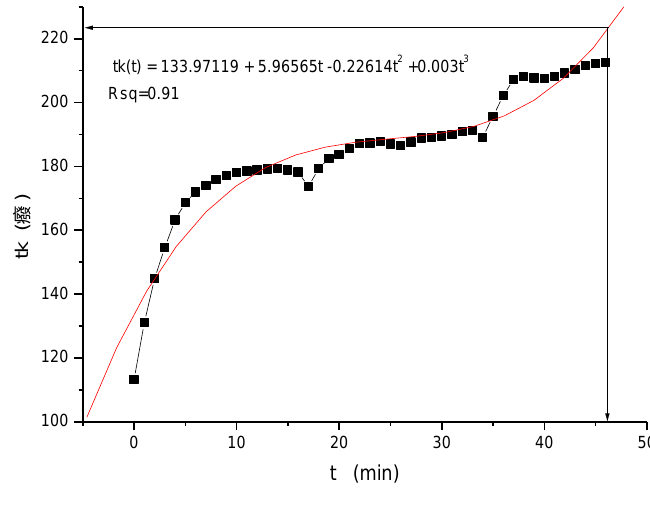
Figure 12. Dependence of tk on operation time.